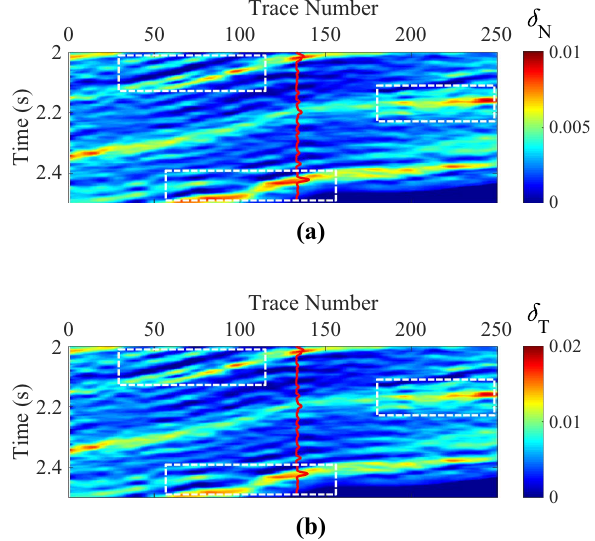
Figure 8. Inverted normal and shear fracture weaknesses in time domain, where (a) is the normal fracture weakness, and (b) is the shear fracture weakness, respectively.